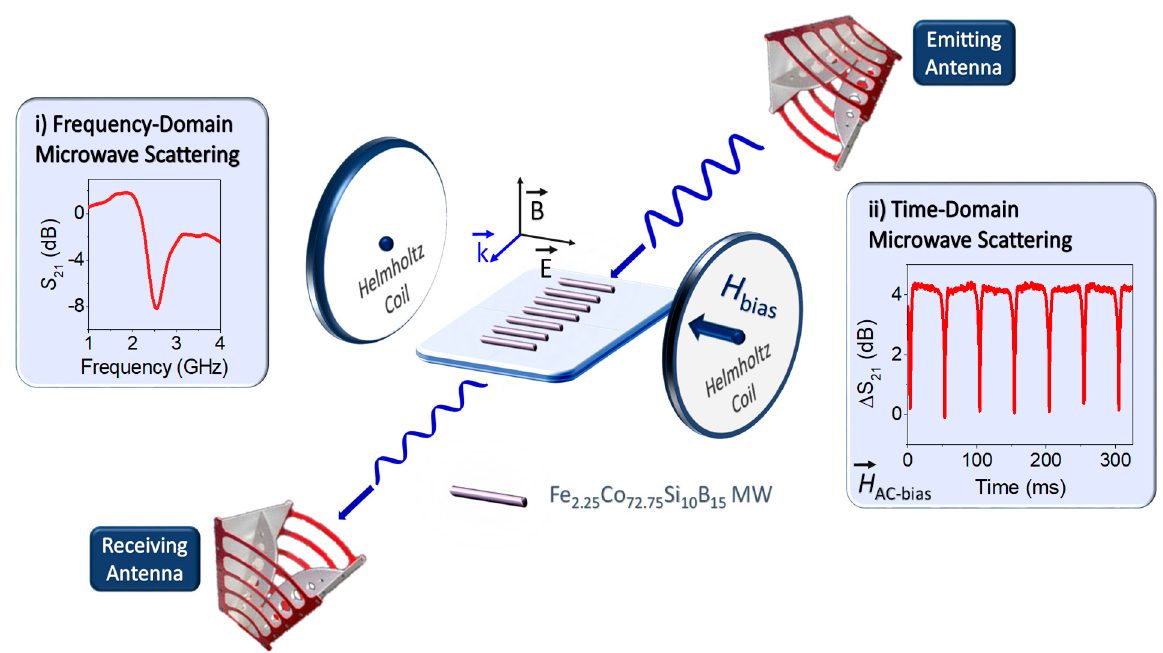
Figure 1. Schematic representation of the microwave scattering mechanism in transmission mode for sensing array platforms composed by Fe 2.25 Co 72.75 Si 10 B 15 (lengths of a few cm). Two Helmholtz coils apply axial magnetic fields to induce large changes in the magnetic state of the Co-based microwires (MWs) and then, giant magneto-impedance (GMI) effects arises. The S 21 transmission coefficient is obtained in the ( i ) frequency and ( ii ) time domains.